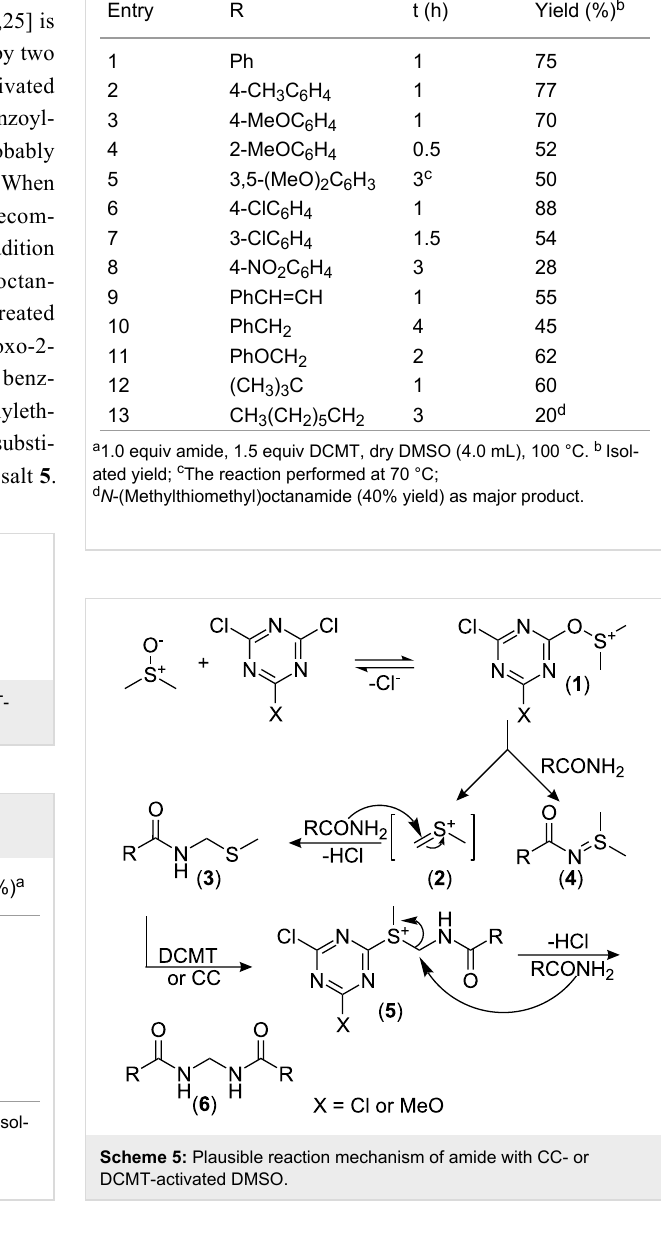
Table 4: Scope of the synthesis of N , N ′-methylenebisamide using DCMT-activated DMSO a. Entry